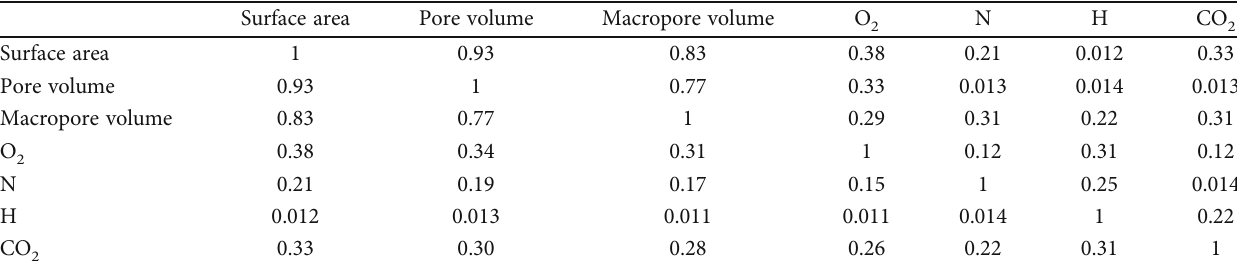
: oxygen, and CO adsorption (mmol/g). 2 2